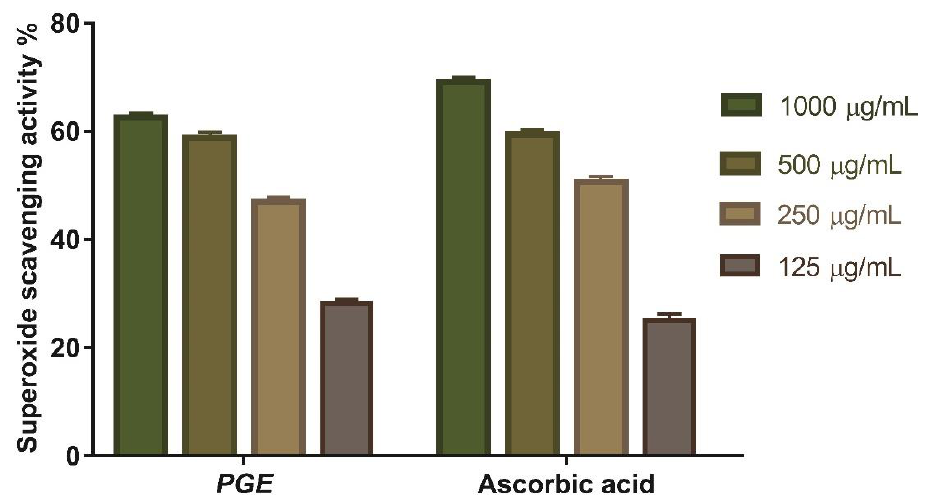
Figure 7. Superoxide radical scavenging activity of Psidium guajava seed extract at different concentration (1000 µg/mL, 500 µg/mL, 250 µg/mL, and 125 µg/mL). Bars represent mean ± SD (standard deviation). Significant difference between groups is analyzed by a two-way ANOVA test.